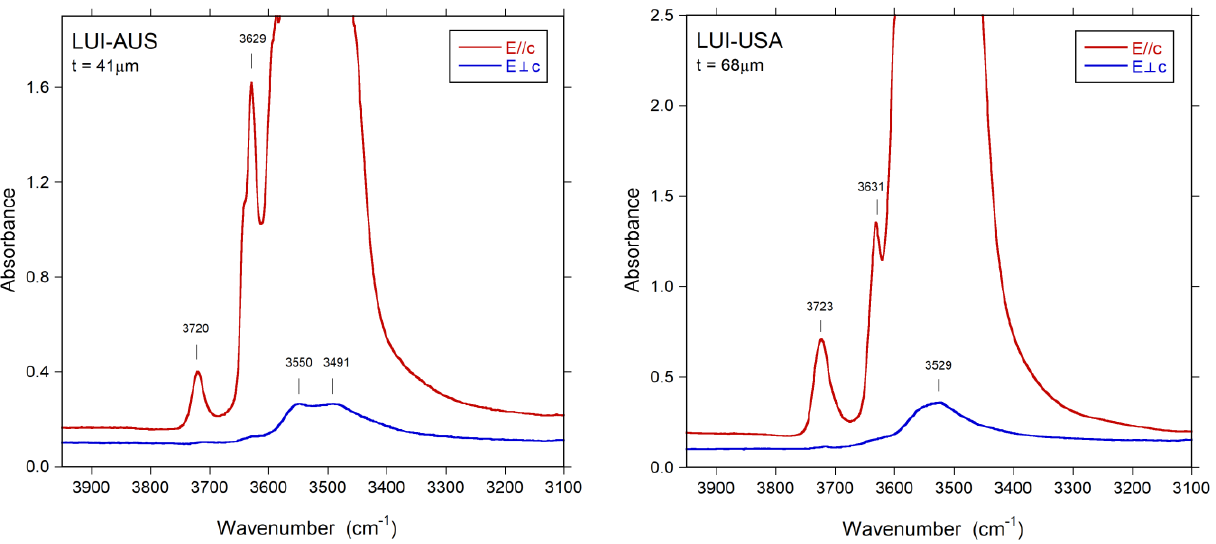
Figure 2. Polarized FTIR spectra of the studied samples in the principal (OH)-range.